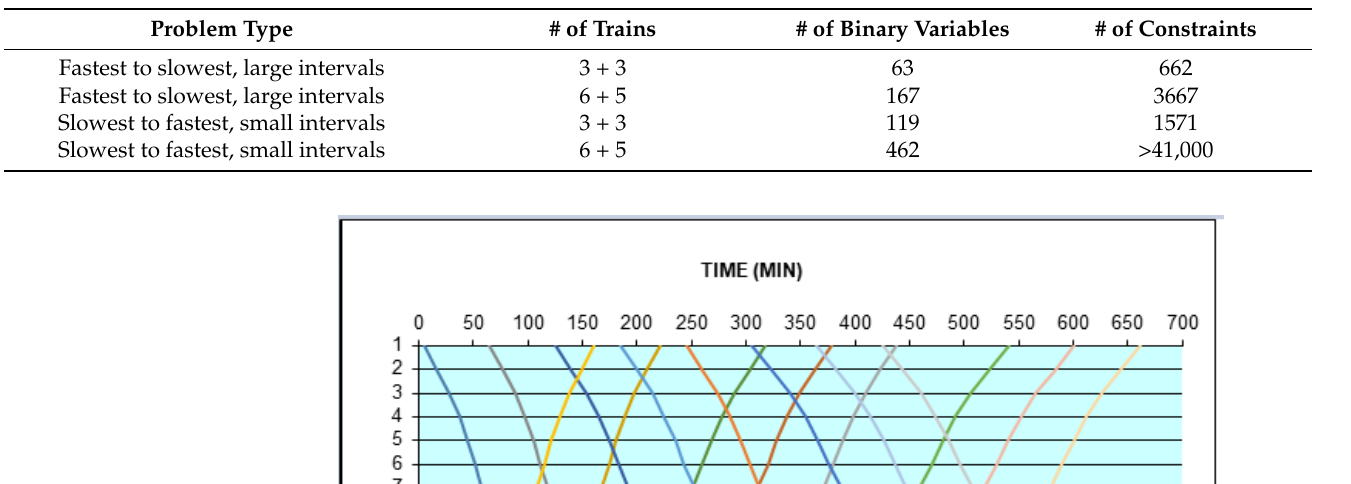
Table 9. Effect of train order and number of eastbound and westbound trains on problem size.